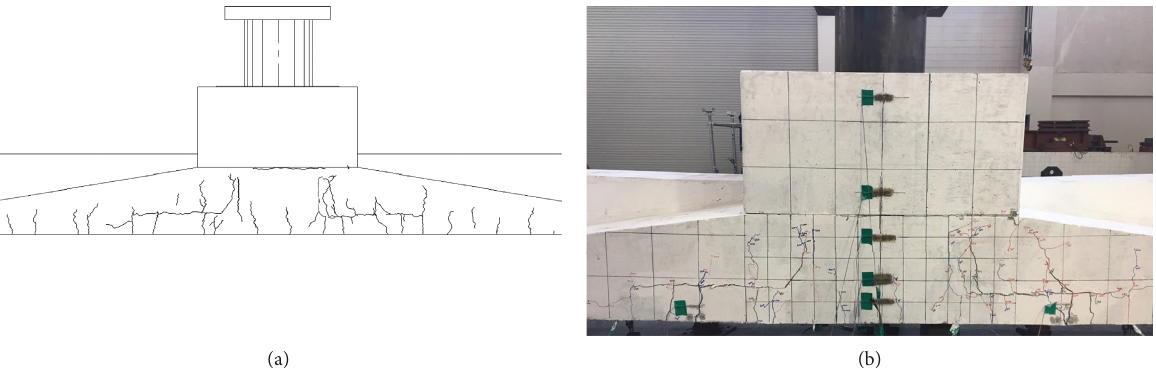
Figure 10: Crack pattern of the specimen. (a) Crack pattern under the maximum load and (b) final